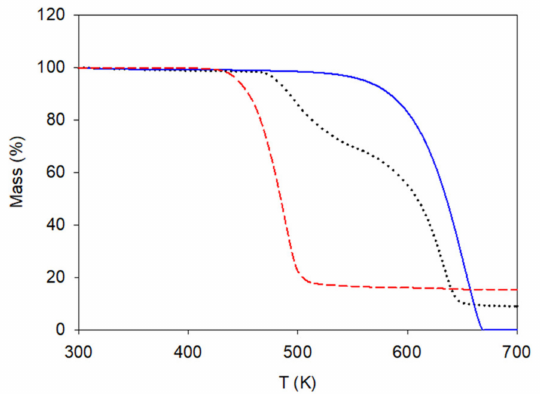
Figure 2. Dynamic TGA thermograms of the eutectic mixture (black, dotted line), AOT (red, dashed line), and PEG-600 (solid, blue